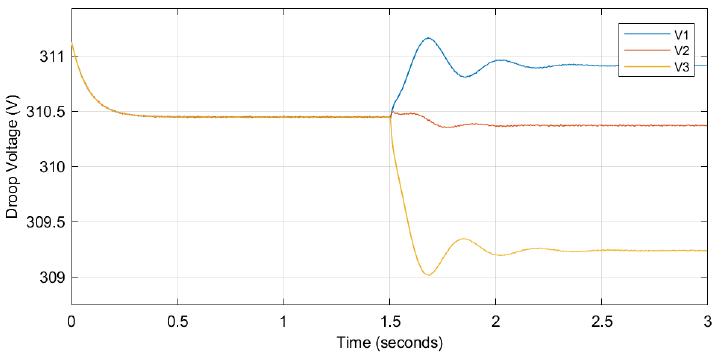
Figure 7. v dpq drop in voltage due to proposed virtual impedance.